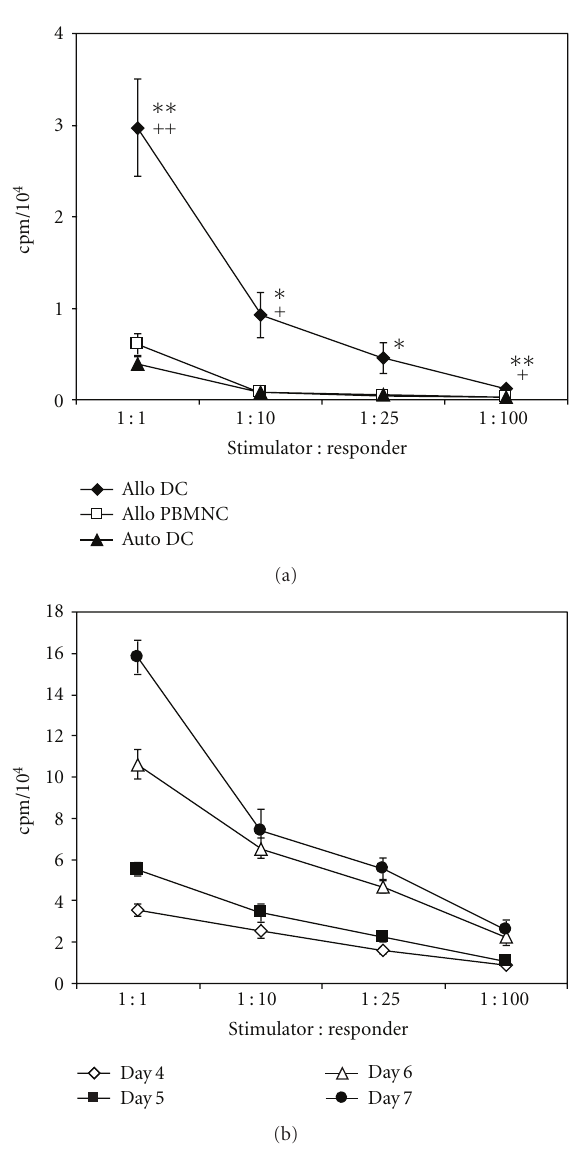
Figure 6: 3 H-thymidine incorporation in MLCs using PBMC- derived DC. MLC measurement was carried out after coculture for 4 days using DC generated from PBMC by FastDC (a). In the same experiment, allogeneic DC were compared with allogeneic PBMC for their stimulation ability, as well as with autologous DC. DC produced from FastDC culture were also used for an MLC time course study from day 4 to day 7 (b). Results are mean ± SEM, n = 3 for three tested samples. ∗ P < 0 . 05, ∗∗ P < 0 . 01 compared with allogeneic PBMC; + P < 0 . 05, ++ P < 0 . 01 compared with autologous DC.